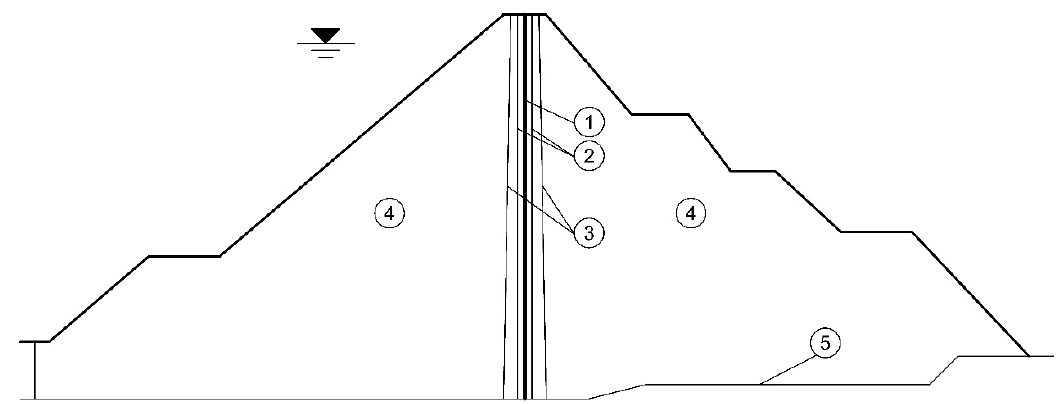
Figure 1. Cross-section of the asphalt concrete core embankment dam. (1) hydraulic asphalt concrete core; (2) fine transition zone; (3) coarse transition zone; (4) rockfill; (5) natural ground surface.